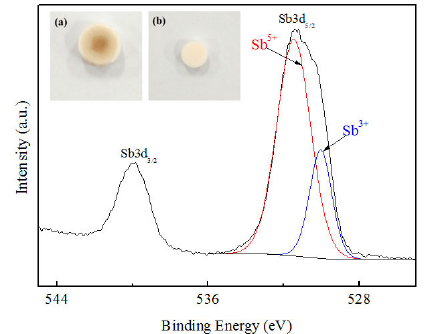
Fig. 7 Sb 3d region of XPS spectra of 1225 ℃ -sintered Li 3 Mg 2 Sb 0.875 O 6 . The inset illustrates the evidence of coring in Li 3 Mg 2 Sb 0.875 O 6 samples fired at different conditions: (a) 1225 and (b) 1250 ℃